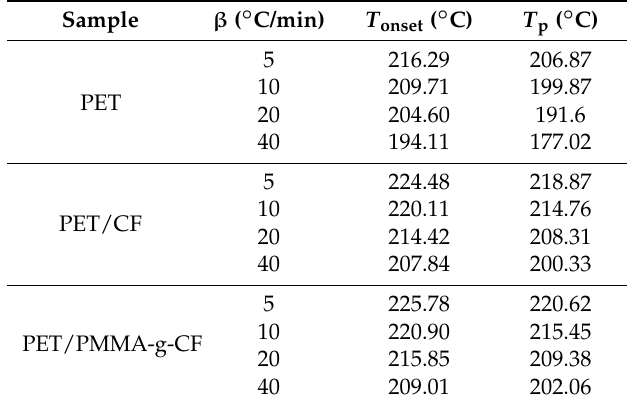
Table 2. Non-isothermal crystallization parameters of pure PET, PET/CF, and PET/PMMA-g-CF composites. Sample